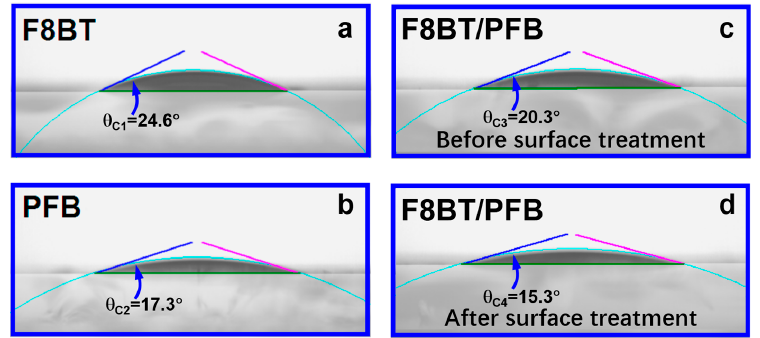
Figure 6. Measurements of the contact angles of colloidal solution of gold nanoparticles with a concentration of 100 mg/mL in xylene dropped onto the surfaces of ( a ) F8BT; ( b ) PFB; and F8BT:PFB blend films before ( c ) and after ( d ) being treated using oxygen plasma.